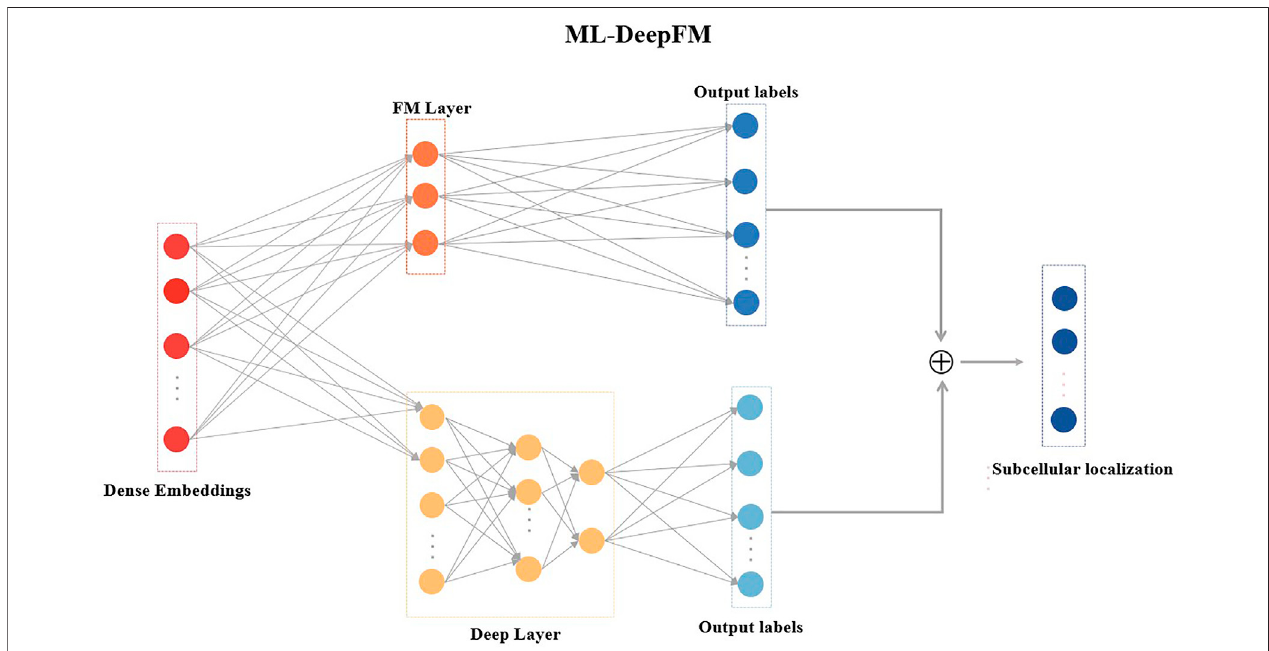
FIGURE 3 | The model architecture of